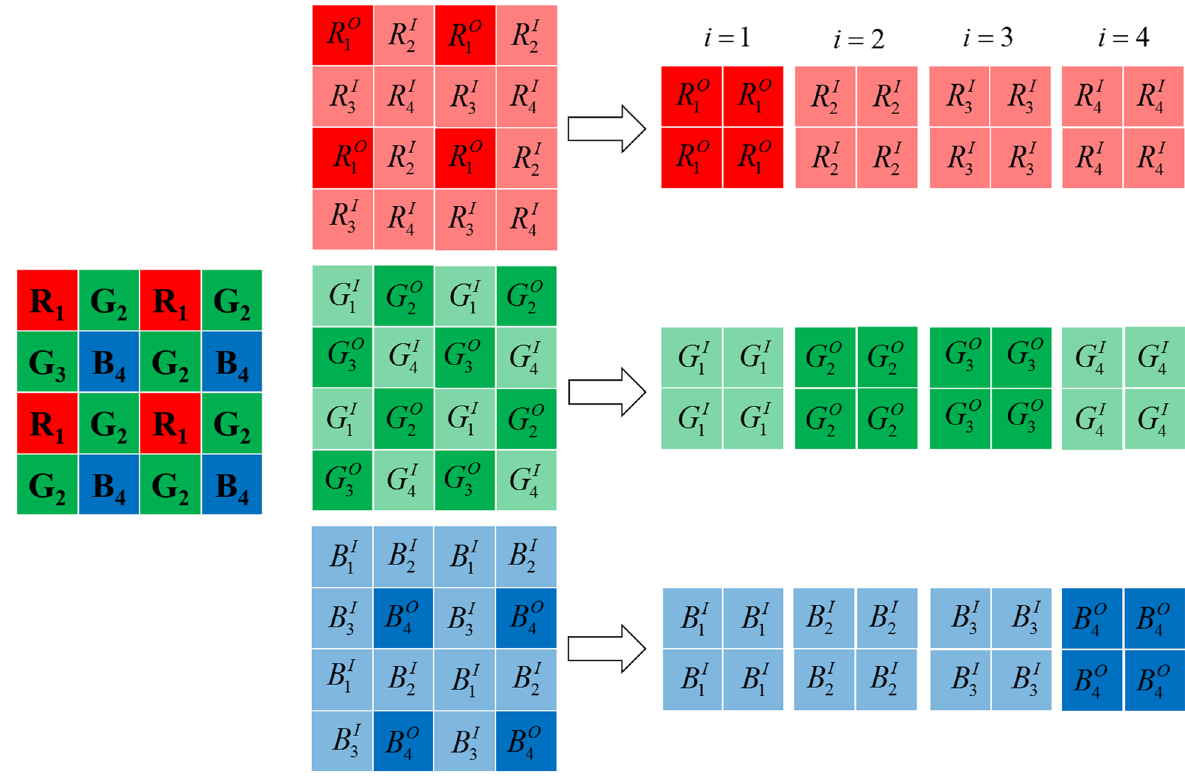
Fig. 4 Example of color component decomposition for RGGB Bayer CFA